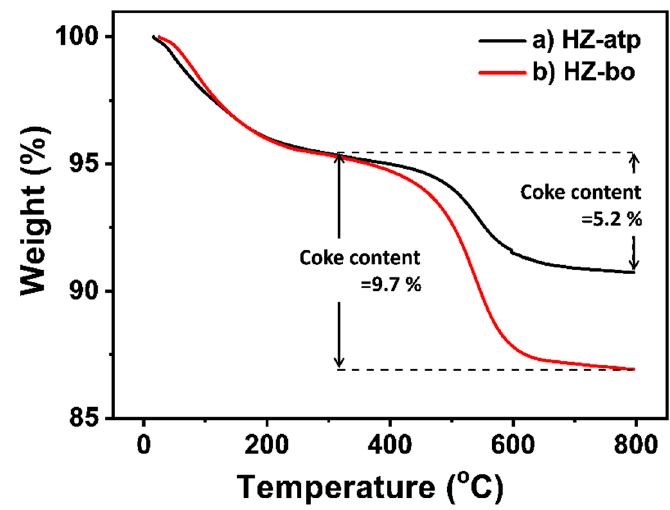
Figure 8. Thermogravimetric analysis (TGA) curves of HZ-atp (black) and HZ-bo (red) after toluene methylation reaction. Coke content was calculated by ([mass of 300 °C] – [mass of 800 °C])/[mass of 800 °C] × 100%.